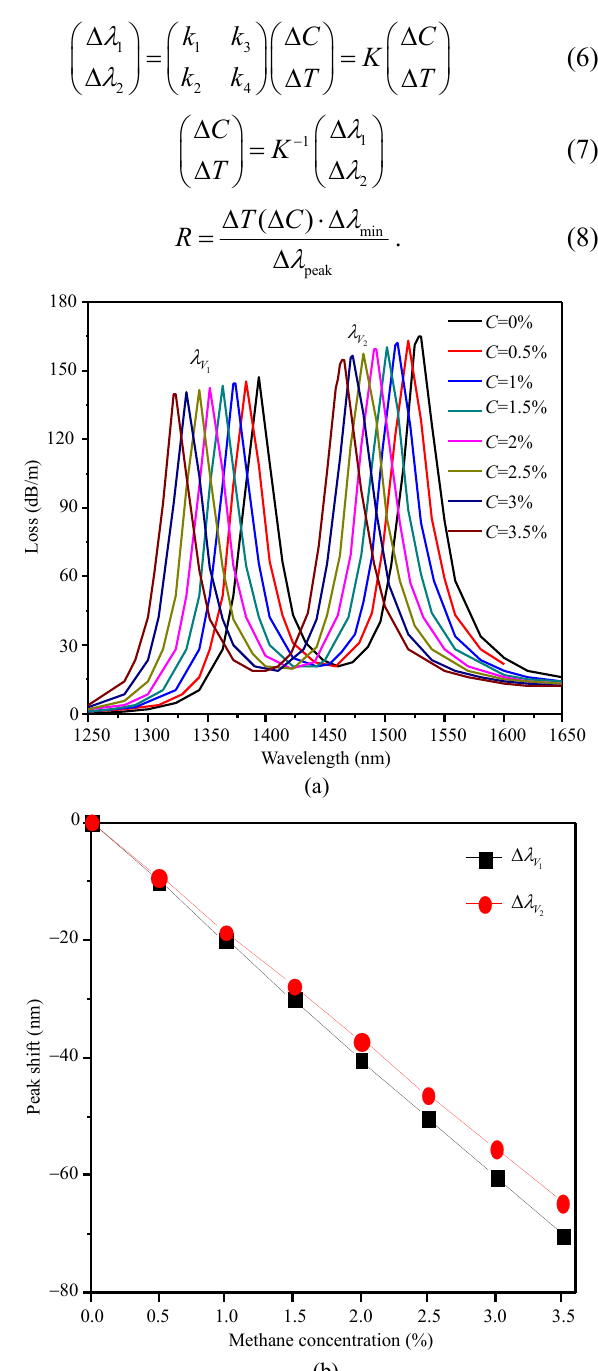
Fig. 8 Loss spectra and the loss-peak shift with different methane concentration C , (a) the loss-peak shift of LP 01 mode and (b) the relationship between the loss-peak shift and C